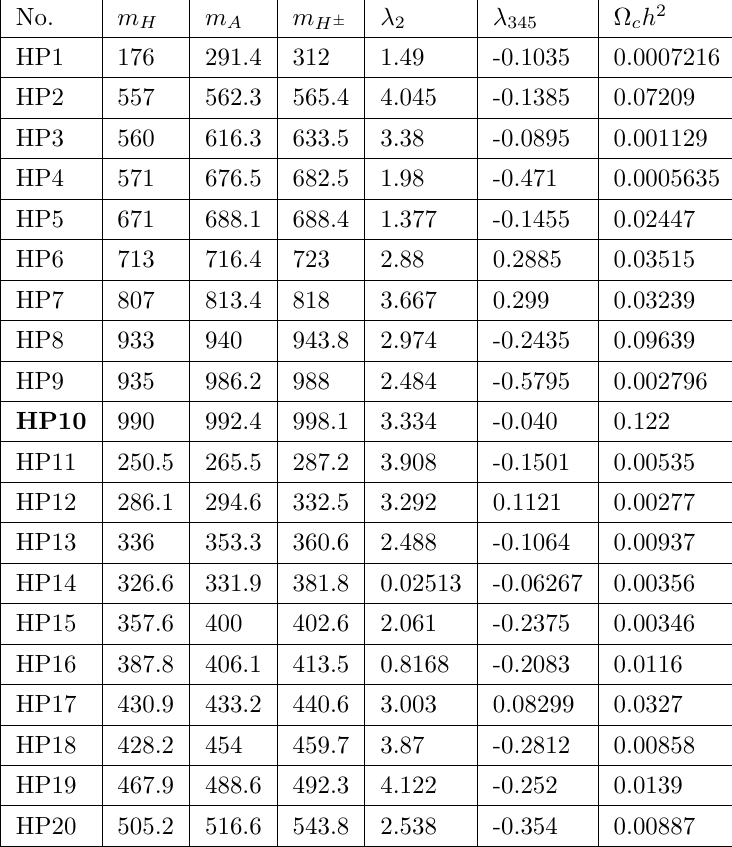
Table 2 . Additional set of high mass IDM benchmark points considered in the presented study, taken from [4]. In all benchmarks m h = 125 : 1 GeV. For HP10 scenario (bold) H completely saturates DM relic density; the value of the (cid:21) 345 parameter for this scenario was slightly modi(cid:12)ed with respect to [4], to be consistent with the most recent results on the relic density